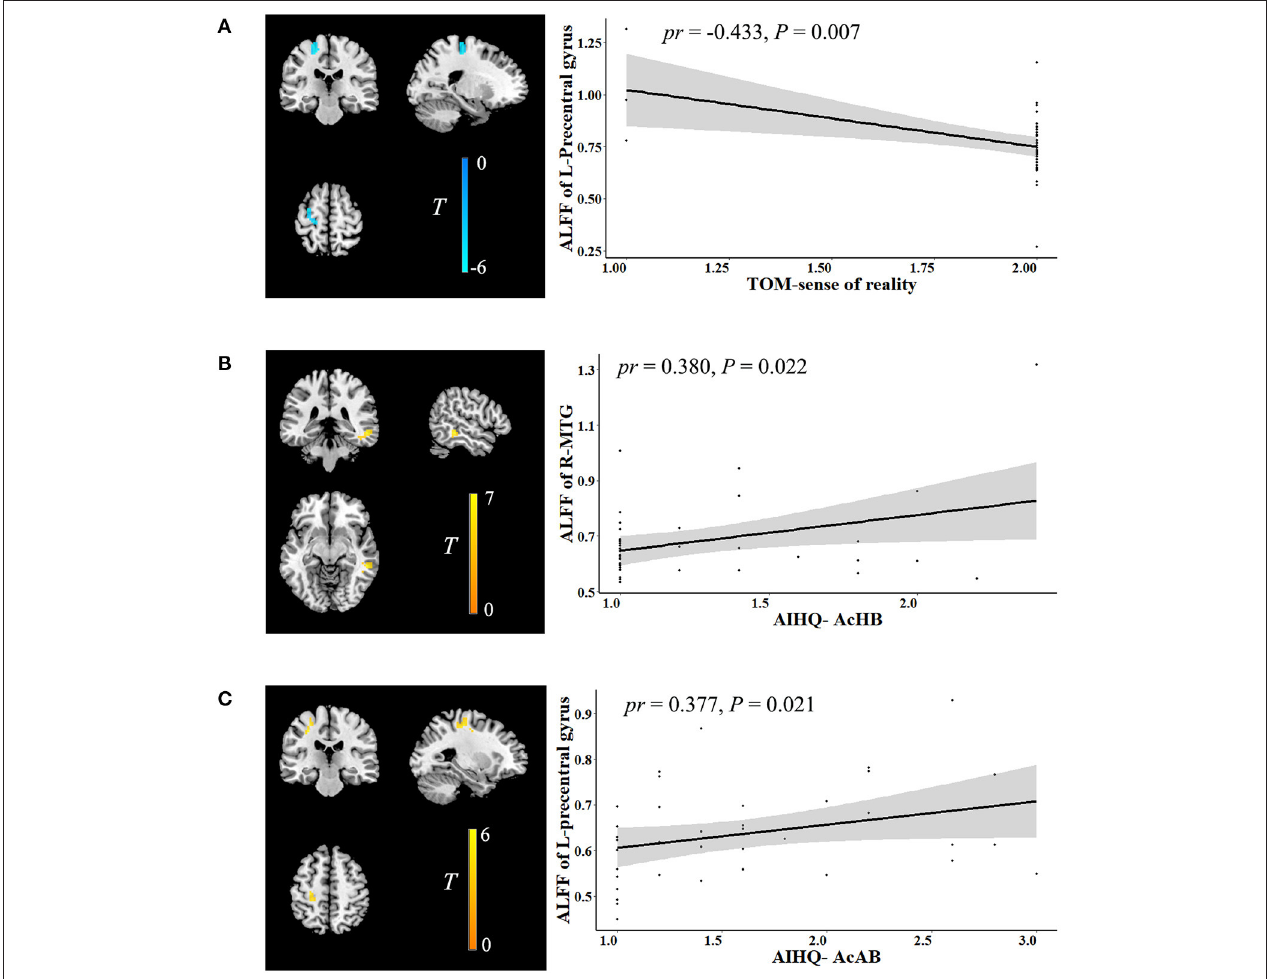
FIGURE 2 | Correlation between social cognition and ALFF. The left figure in (A–C) is voxel-based and the right is ROI-based. (A) Correlation between ALFF in the left precentral gyrus and TOM-sense of reality. (B) Correlation between ALFF in the right MTG and AIHQ-AcHB. (C) Correlation between ALFF in the left precentral gyrus and AIHQ-AcAB. ALFF, amplitude of low-frequency fluctuation; ROI, region of interest; TOM, theory of mind; AIHQ, ambiguous intentions hostility questionnaire; AcHB, accidental hostility bias; MTG, middle temporal gyrus; AcAB, accidental aggression bias; pr , partial correlation coefficient; L, left; R,